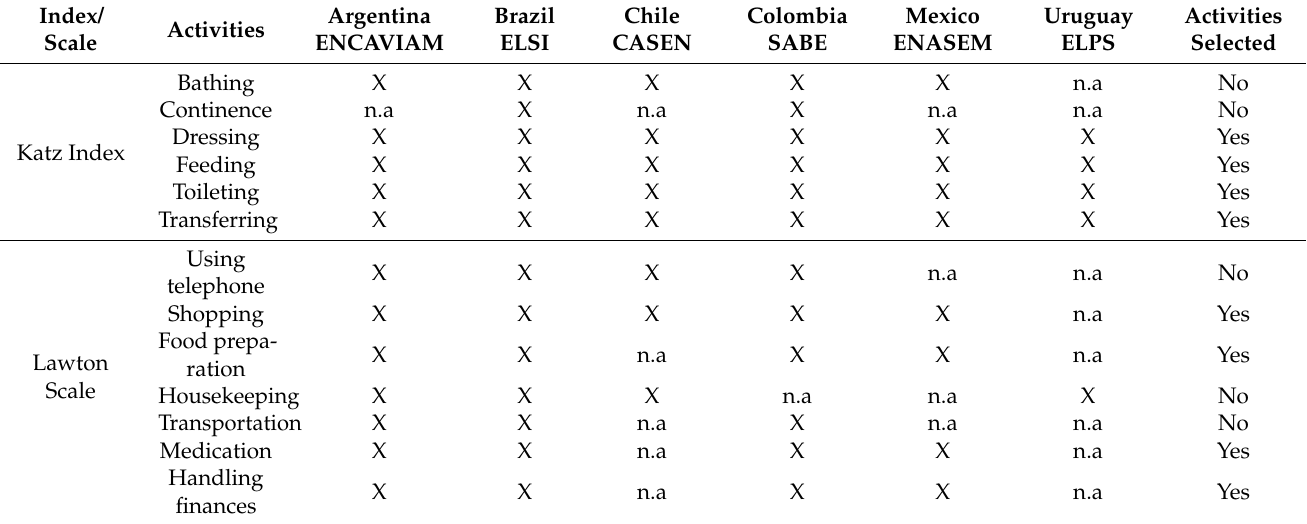
Table 3. Activities of the Katz Index and activities of the Lawton scale included in the study, by country/survey. Index/